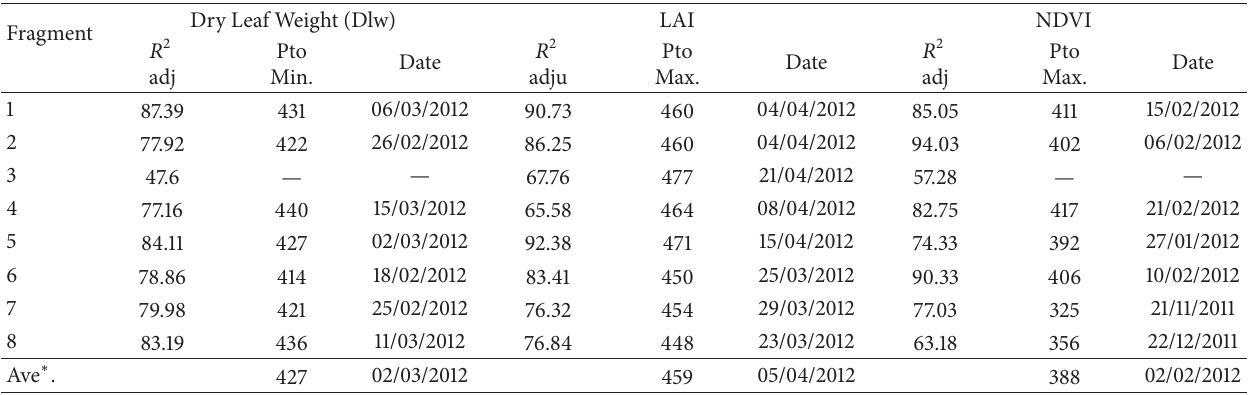
Table 3: Coefficients of determination ( 𝑅 2 adjusted) for polynomial equations in the observed dry leaf weight (g ⋅ m − 2 ), LAI (m 2 ⋅ m − 2 ), and NDVI data and respective minimum and maximum points by fragment (sequential day from